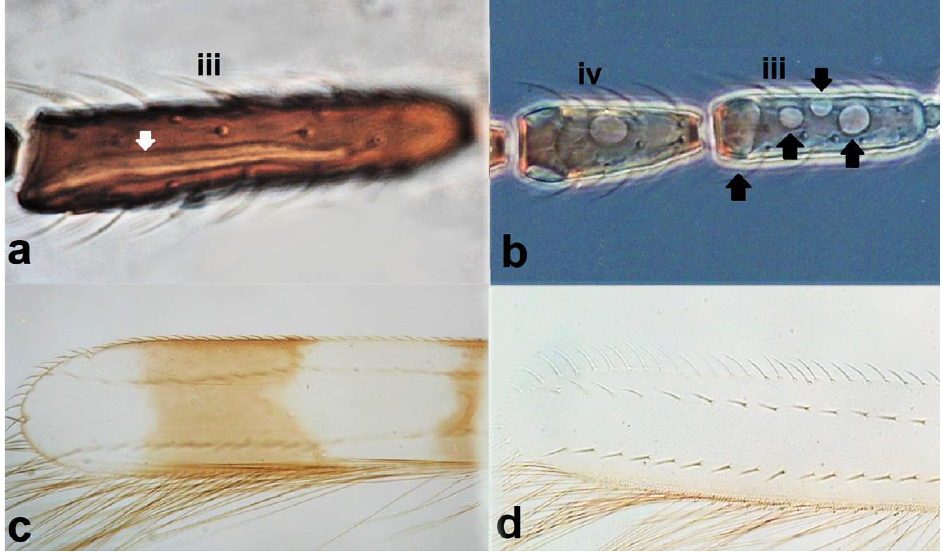
Figure 6. Antennal sensoria on segment III ( a , b ): ( a ) continuous and ridge-shaped; ( b ) lens-shaped; fore wing ( c , d ): ( c ) broad and banded; ( d ) narrow and monochrome. 6 Fore wing margin at tip as light as wing membrane (Figure 7a) …………………….. 7 Fore wing margin at tip darker than wing membrane (Figure 7b) …………………. .. 8